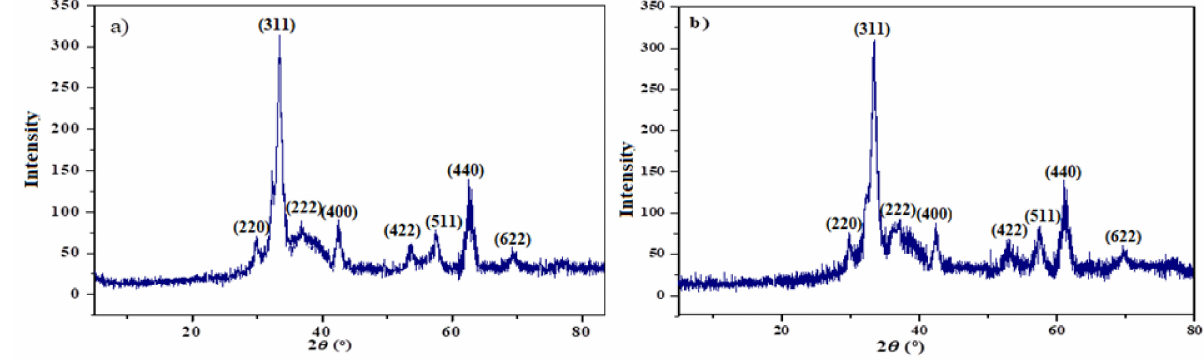
Figure 3. XRD-diffraction pattern of ( a ) OA-MNPs and ( b ) DA-MNPs.